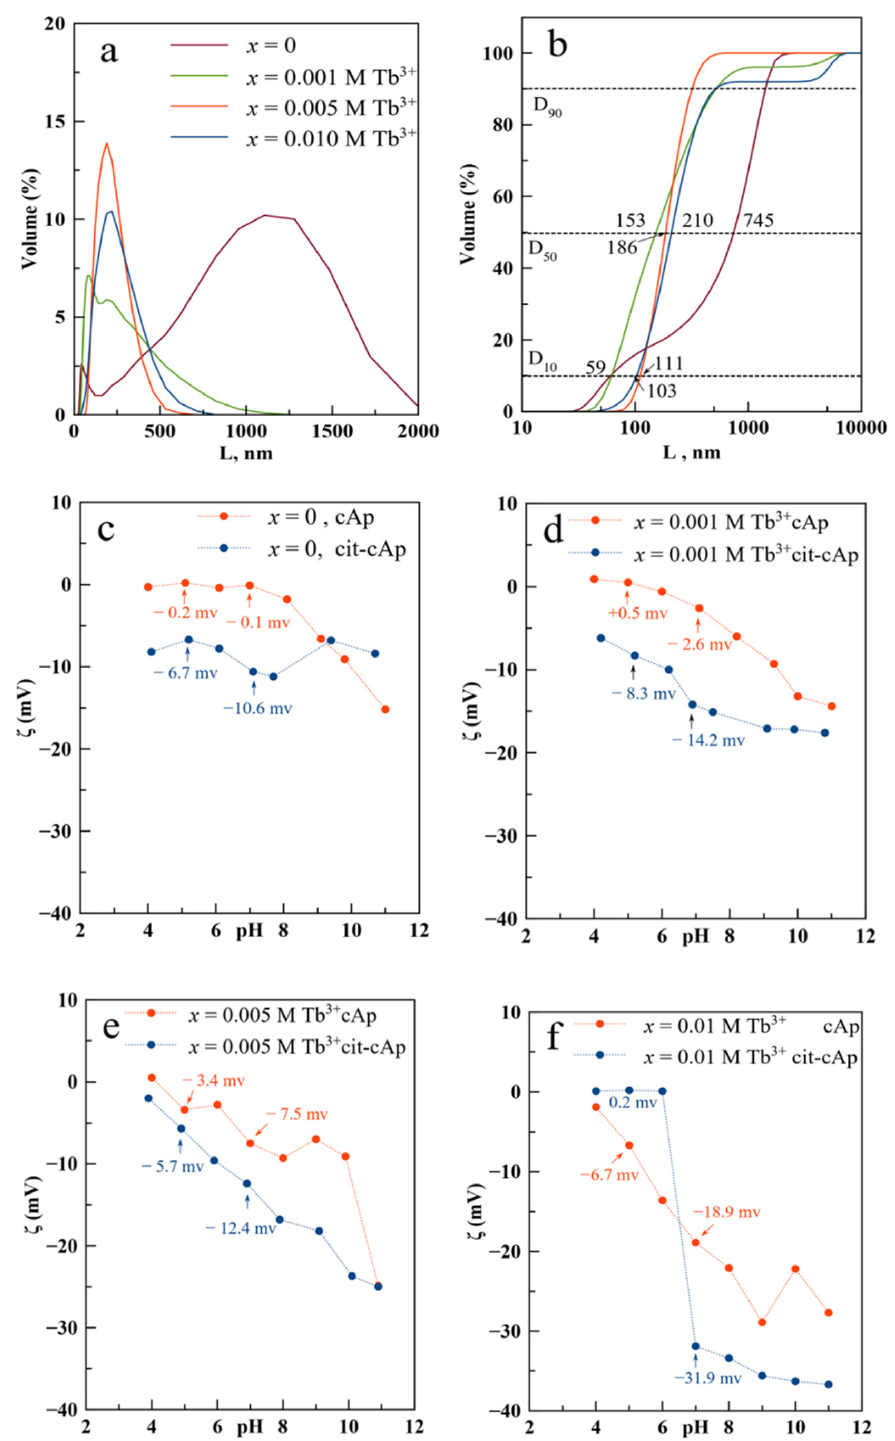
Figure 4. ( a ) Volume based PSD, ( b ) cumulative volume based PSD, and ( c – f ) ζ -potential versus pH of Tb 3+ :cit-cAp and Tb 3+ :cAp nanoparticles prepared with Tb 3+ doping concentrations x = 0, 0.001, 0.005 and 0.010 M for 96 h.